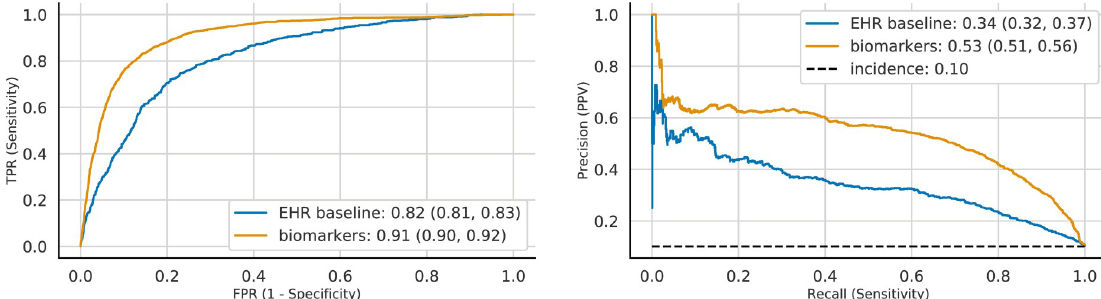
Fig 4. Automated diagnosis of exudative AMD. Curves correspond to models trained on different feature sets (see legend). Left . Receiver Operating Characteristics (ROC). Right . Precision-Recall curve (PRC). 95% Confidence intervals were computed using bootstrapping. Baseline model utilizes EHR-derived features and risk factors, the biomarker model includes machine-read OCT biomarkers too.